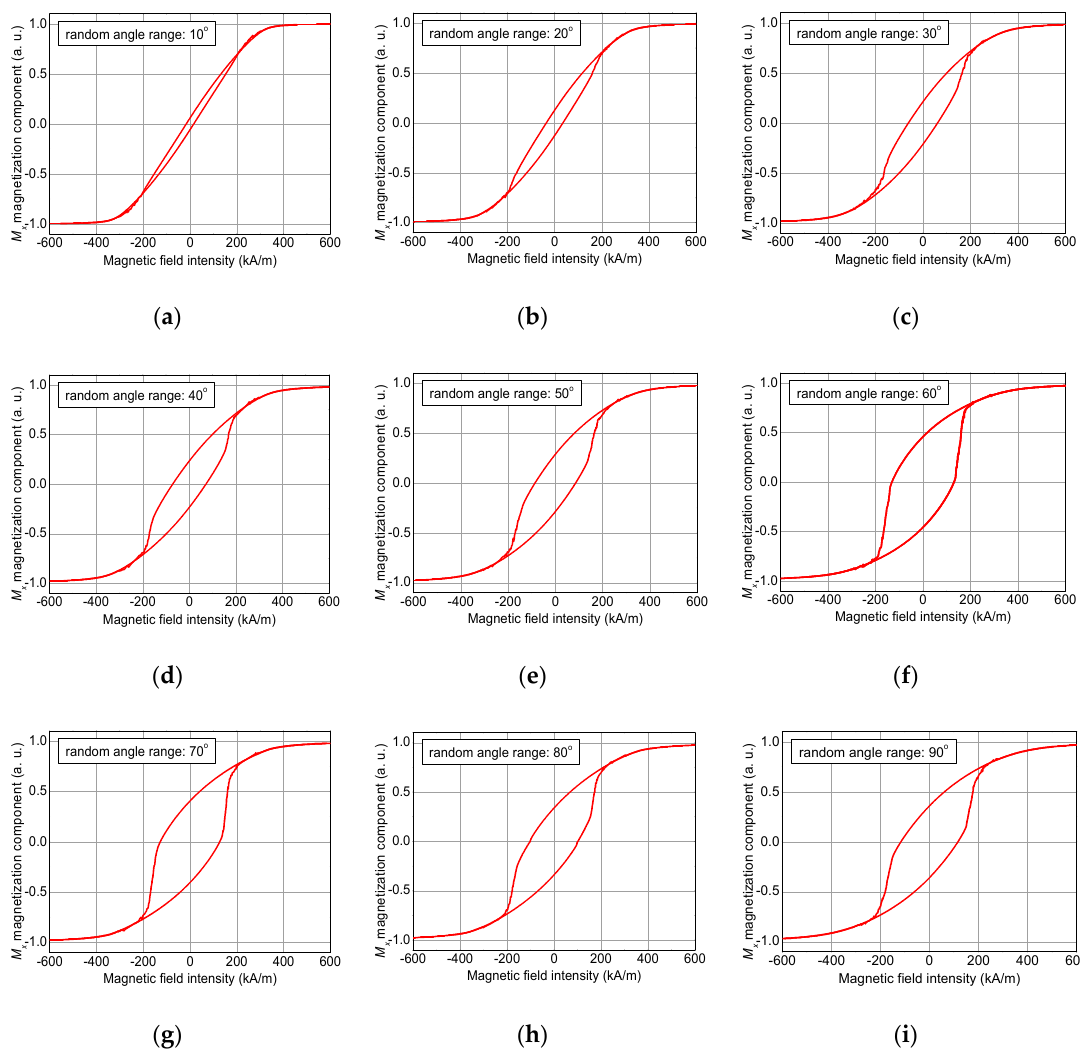
Figure 14. Hysteresis loops, simulated for an external magnetic field sweep along the x-axis and random angle ranges, depicted in steps of 10°: ( a ) 10°, ( b ) 20°, ( c ) 30°, ( d ) 40°, ( e ) 50°, ( f ) 60°, ( g ) 70°, ( h ) 80°, and ( i ) 90°.